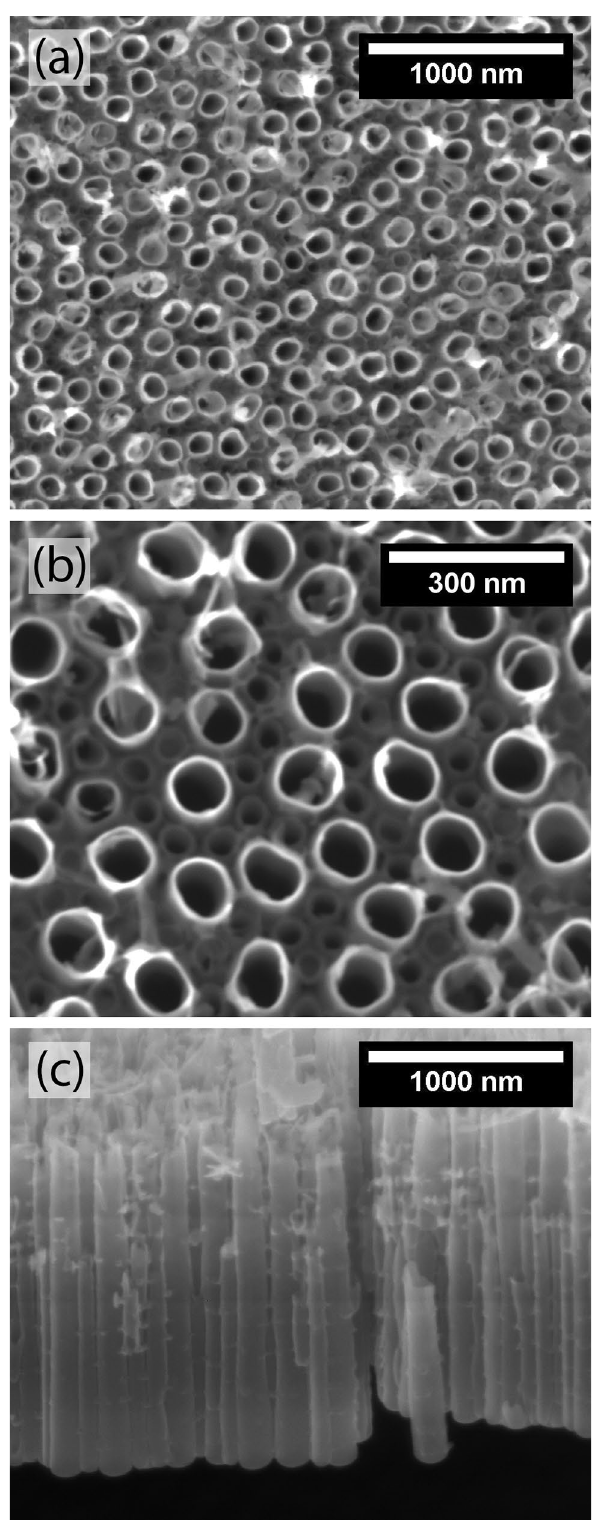
Figure 3. FEG-SEM micrographs of a TNZT sample anodized in the aqueous electrolyte at 20 V for 1 h. ( a , b ) Top-view and ( c ) side-view